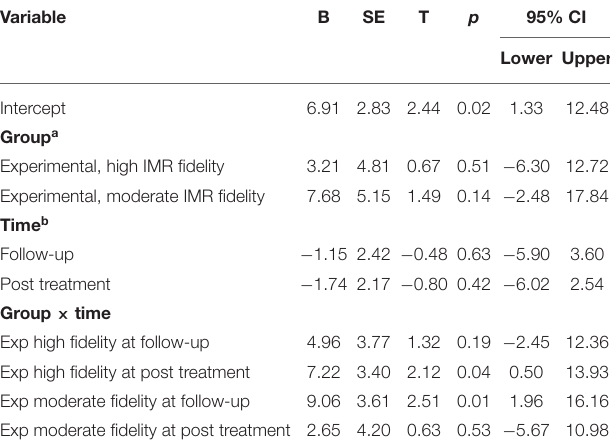
TABLE 5 | Fixed coefficients for linear mixed model (SERS-SF) on time effects for high and moderate IMR fidelity.